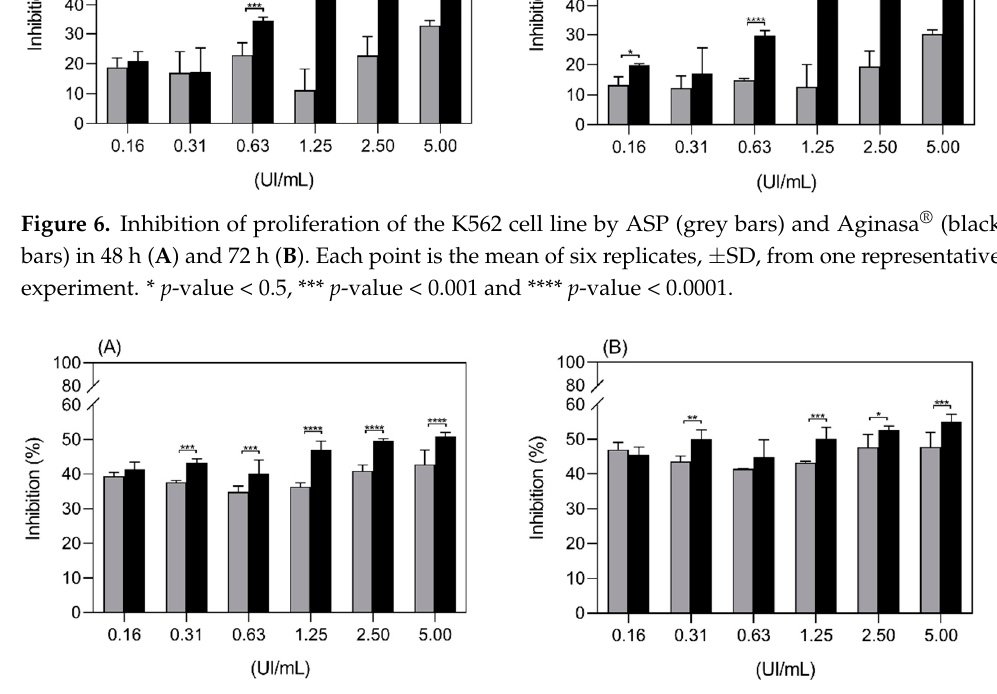
Figure 7. Inhibition of proliferation of the Jurkat cell line by ASP (grey bars) and Aginasa ® (black bars) in 48 h ( A ) and 72 h ( B ). Each point is the mean ± SD, from one representative experiment. * p -value < 0.5, ** p -value < 0.01, *** p -value < 0.001 and **** p -value < 0.0001.